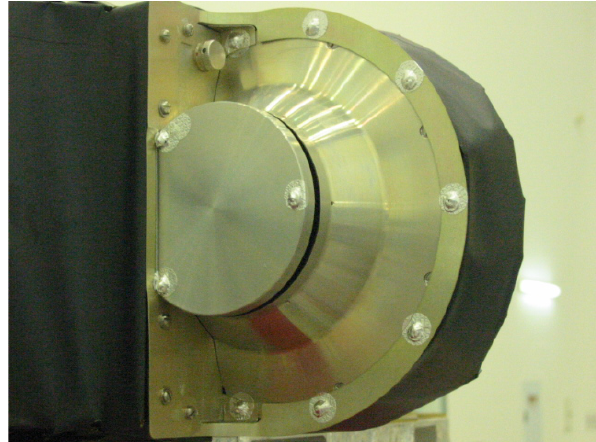
Figure 8. Photograph of TC-2 PEACE Sensor head showing arrangement of electrostatic